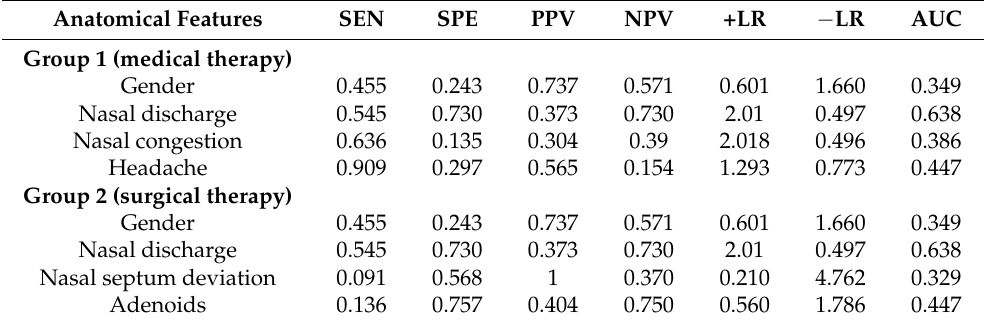
Table 1. Values of single-marker detection for patients with medical therapy and surgical therapy. Anatomical Features